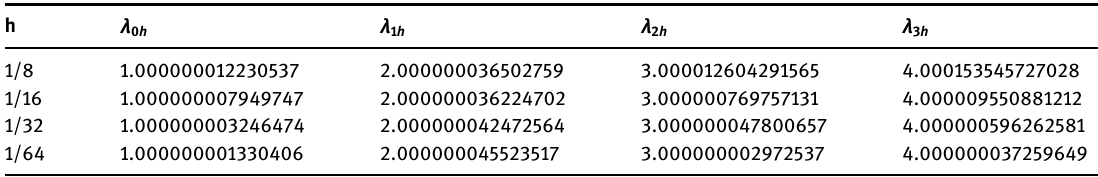
Table 2: Eigenvalues for